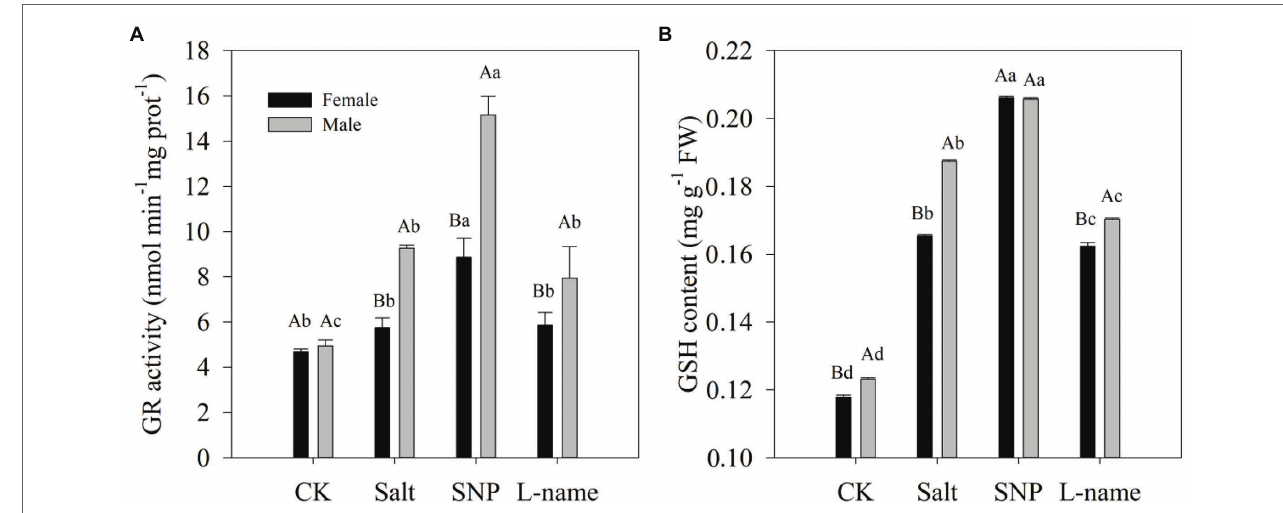
FIGURE 6 | Glutathione reductase (GR) activity (A) and GSH content (B) of T. grandis in response to different treatments. CK (control, distilled water), salt (100 mM NaCl), SNP (100 mM NaCl with 0.05 mM SNP), and L-name (100 mM NaCl with 0.5 mM SNP and L-name). Different uppercase letters indicate a significant difference between different genders at p < 0.05, and different lowercase letters indicate significant difference under salt treatment at p < 0.05, according to Duncan’s